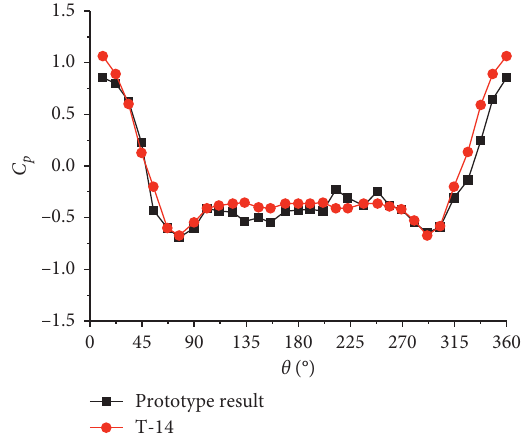
Figure 16: Comparison with the measured value and test value for the wind pressure